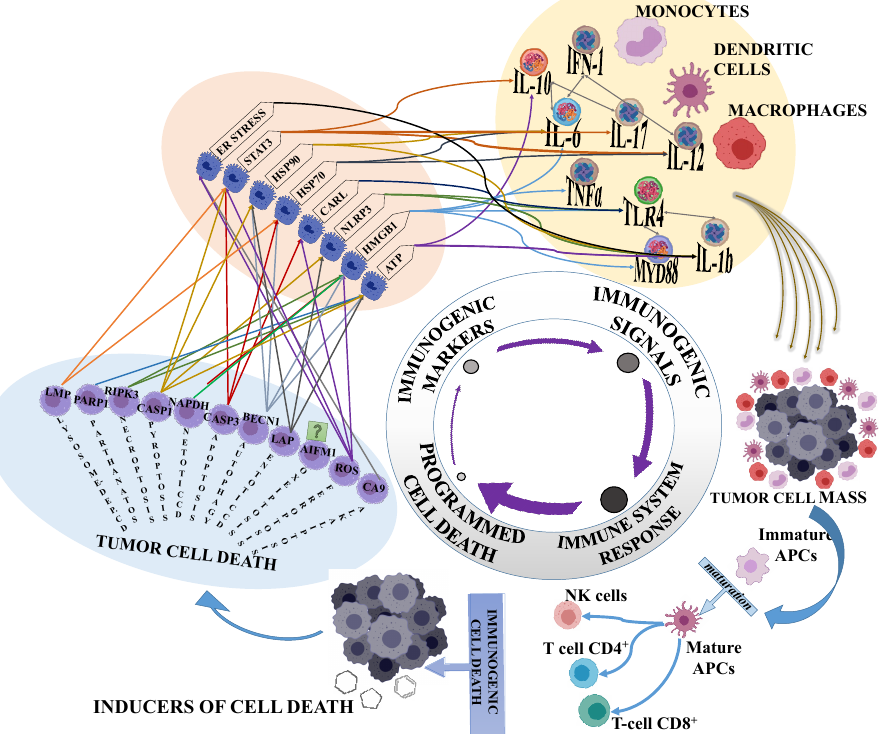
Figure 1. From programmed cell death to immunogenic stimulation. Specific cell death pathways instruct the production of immunogenic markers that in turn stimulate innate immune cells (macrophages, dendritic cells and monocytes) to enhance immune anticancer response, through priming and differentiation of adaptive immune cells (CD4 + , CD8 + and B cells), as well as natural killer cells (NK) cells. The combination and cooperation of cell death and immunogenic stimuli could contribute to increase the therapeutic success to eliminate tumour cell mass.